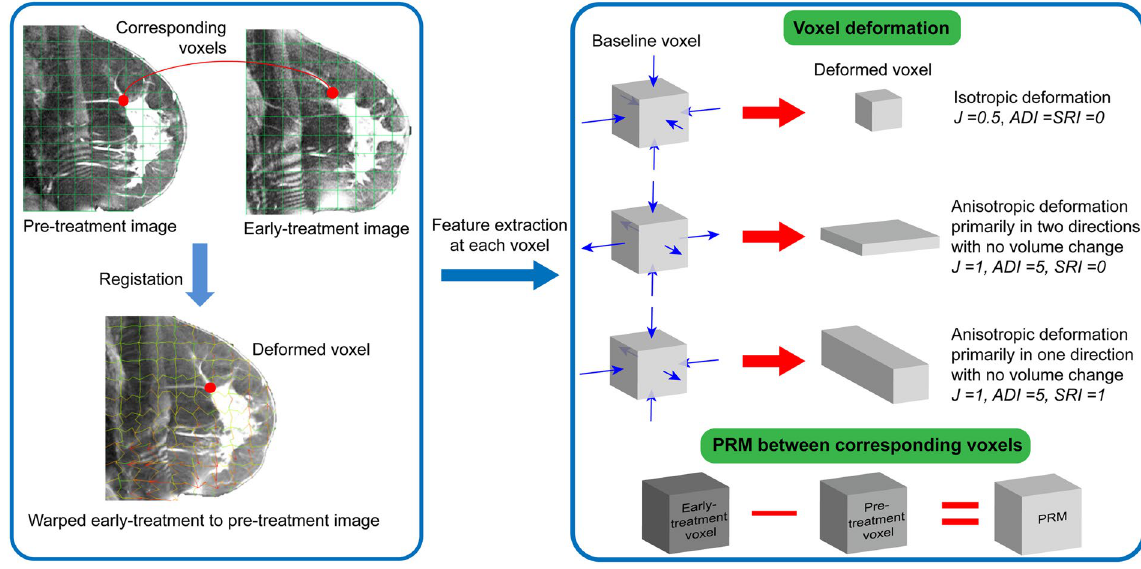
Figure 2. Deriving the deformation field from image registration (left) to extract longitudinal voxel-wise image features